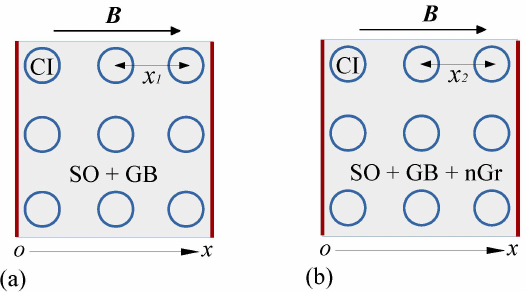
Figure 6. Schematic representation of the arrangement of CI microparticles in hMACs and hEMACs, in the presence of a magnetic field with density B . Here, x 1 and x 2 are the distances between magnetic dipoles center-of-masses, ox-is the coordinate axis, while SO, GB and nGr are silicone oil, gauze bandage, and respectively graphene nanoplatelets. (a) SO + GB (b) SO + GB +